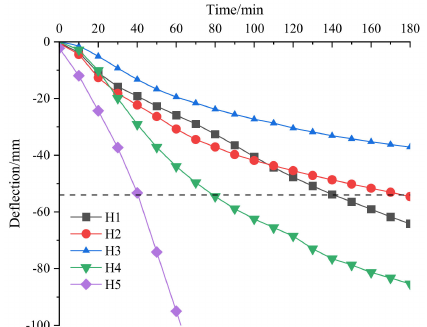
Figure 9. Variation curves of span deflection under different fire modes.